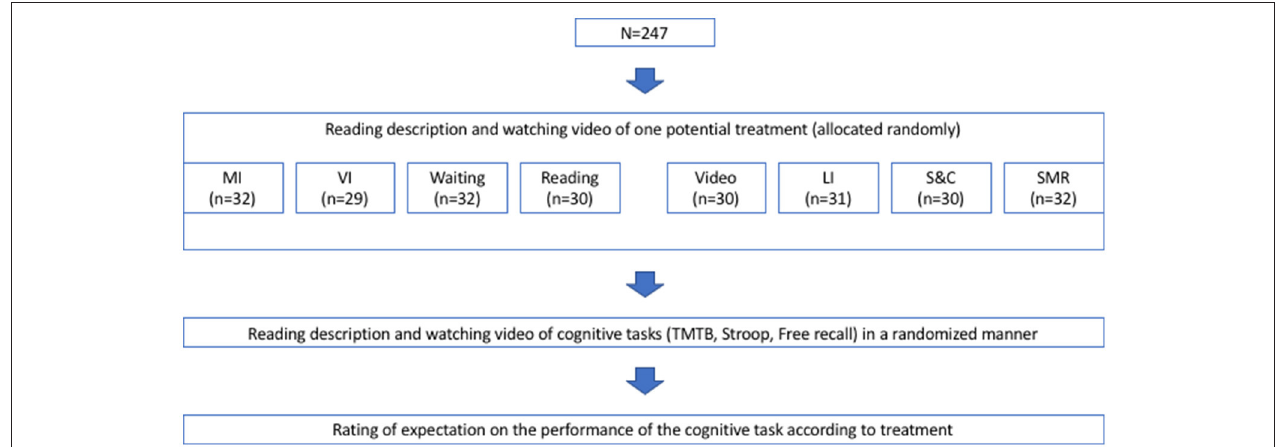
FIGURE 1 | Experimental procedure TMT, Trail Making Test; n, sample size; MI, supervised bicycle ergometer training session at moderate intensity; VI, supervised bicycle ergometer training session at vigorous intensity; LI, supervised bicycle ergometer training session at low intensity; S&C, supervised stretching, myofascial release and coordination training session; SMR, supervised myofascial release training